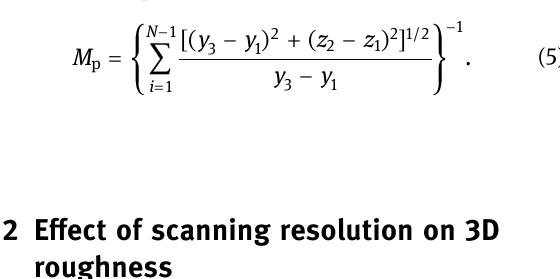
Figure 6: Normal four - pyramid model and